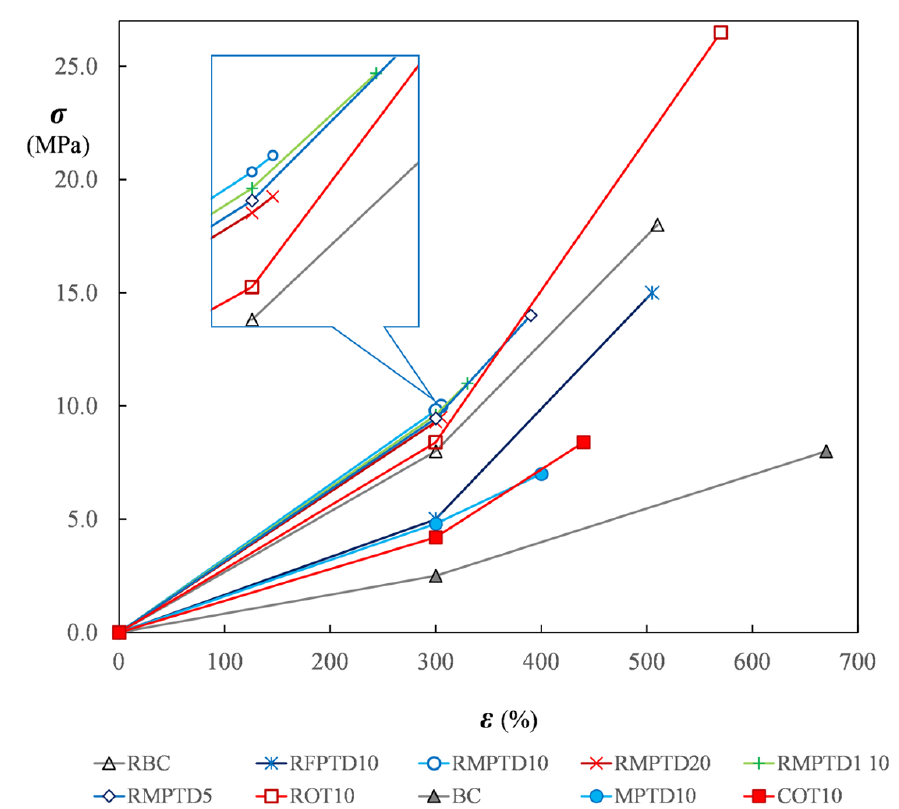
Figure 5. Load-versus elongation curves obtained in tensile tests for leather waste-NR. Experimental results of reinforced and non-reinforced compounds are plotted for